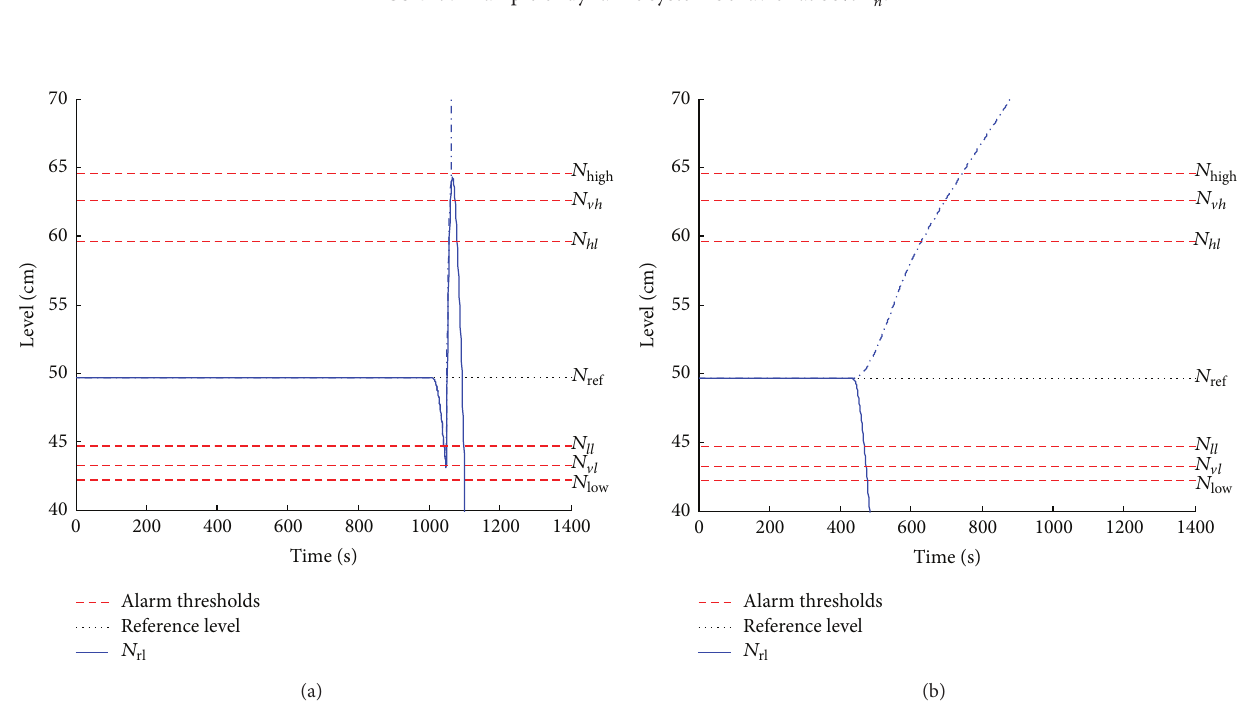
Figure 8: Example of dynamic system behavior at 5% 𝑃 𝑛